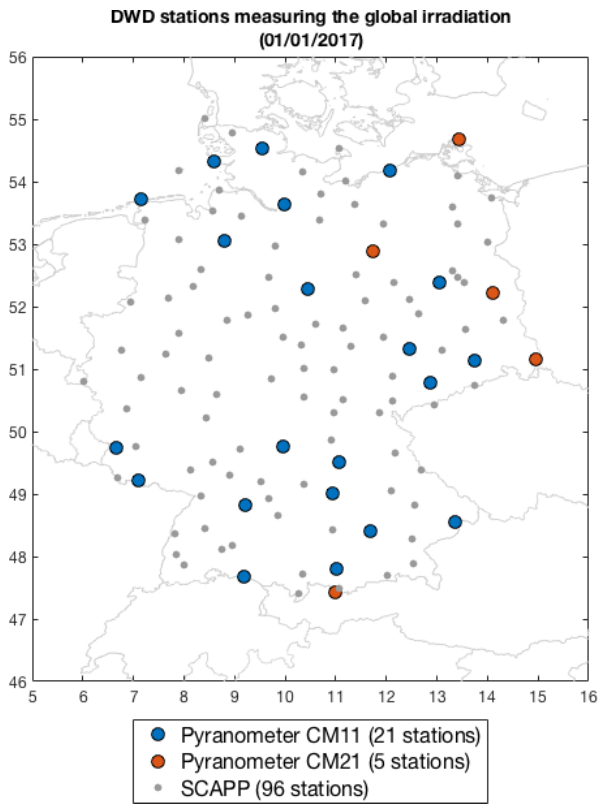
Figure 1. Map of the DWD stations measuring the global radiation valid on 1 January